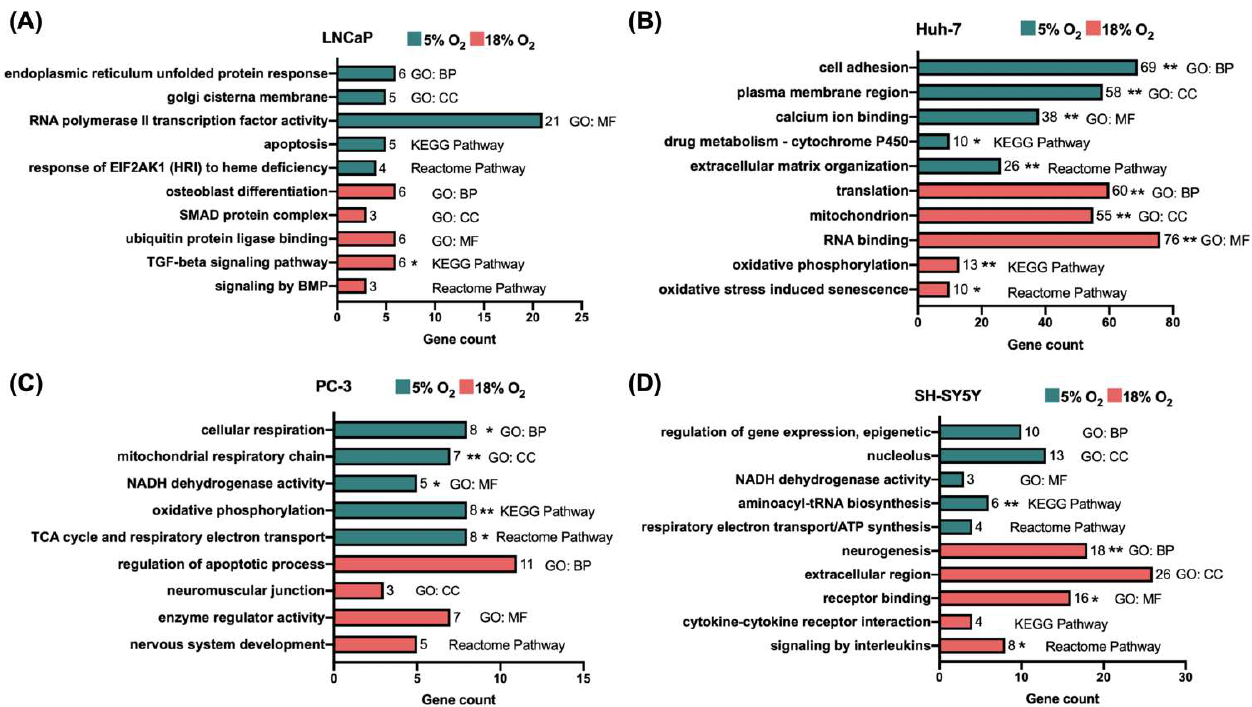
Figure 2. Selection of functional annotation terms enriched at 5% and 18% O 2 in ( A ) LNCaP, ( B ) Huh-7, ( C ) PC-3, and ( D ) SH-SY5Y cells. GO, gene ontology; CC, cellular component; MF, molecular function; KEGG, Kyoto encyclopedia of genes and genomes. (* p adj < 0.05, ** p adj < 0.005, otherwise p < 0.05). Other abbreviations: BMP, bone morphogenetic protein; EIF2AK1, eukaryotic translation initiation factor 2 alpha kinase 1; HRI, heme-regulated inhibitor; SMAD, SMA (small)— mothers against decapentaplegic; TCA, tricarboxylic acid; TGF, transforming growth factor.